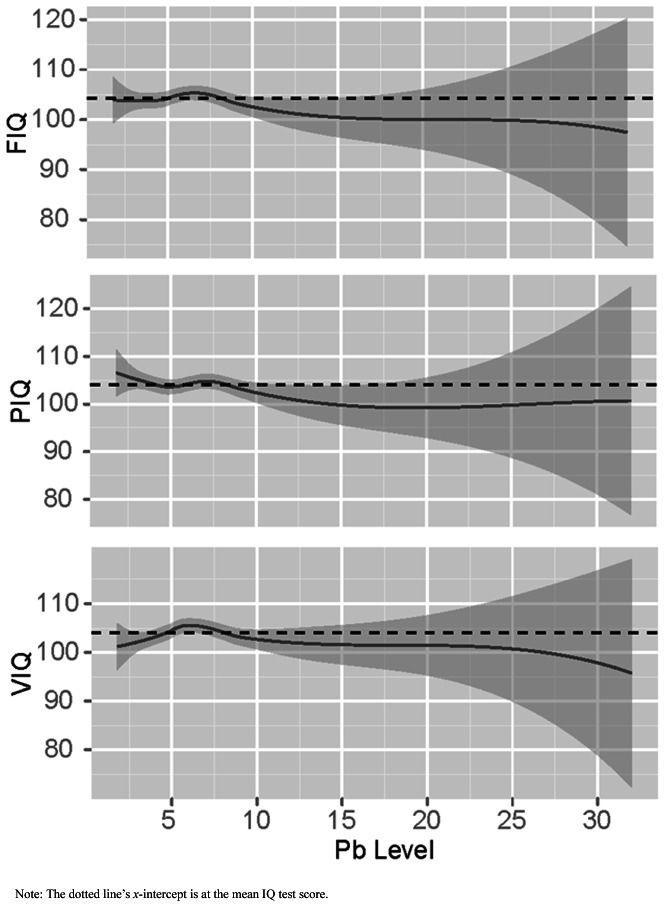
FIQ, VIQ, and PIQ test scores by blood lead concentration (µg/dl) with estimated 95% confidence bands.Note: The dotted line's y-intercept is at the mean IQ test score.